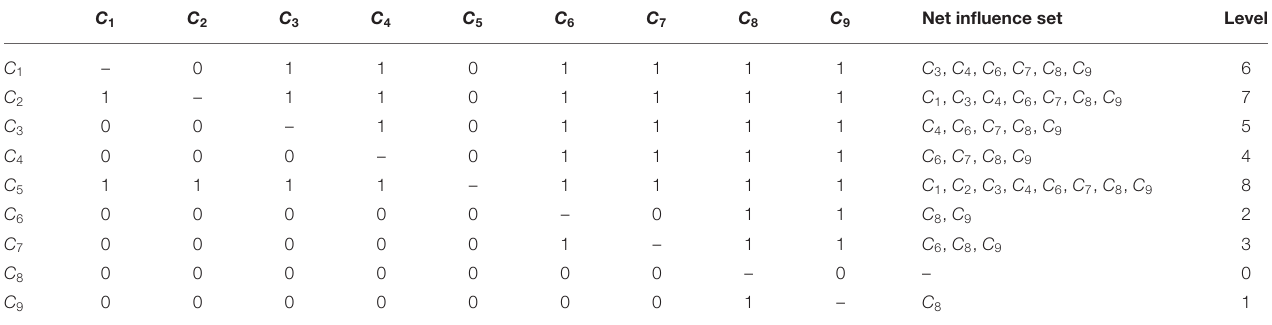
TABLE 6 | The net influence matrix, set and level for each